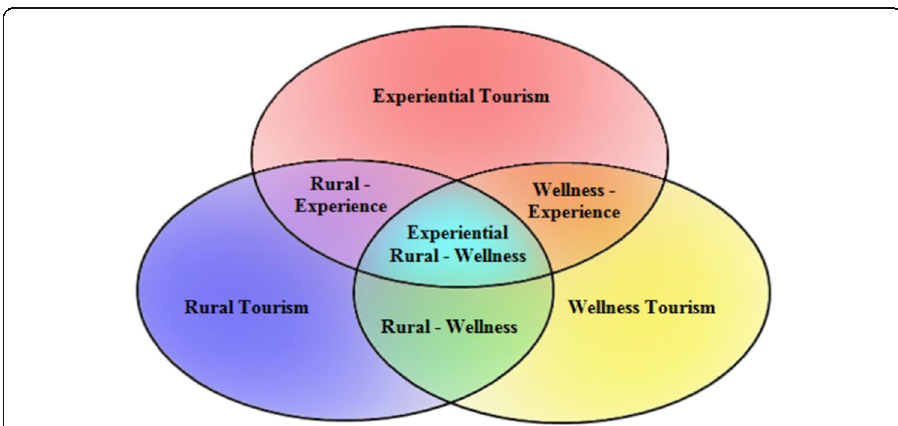
Fig. 3 Segmentation of the tourist market attracted by the Perfume Valley. Source: our